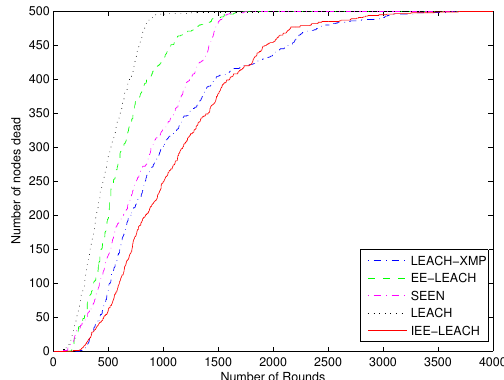
Figure 12. Comparison of life cycles for a large sensor